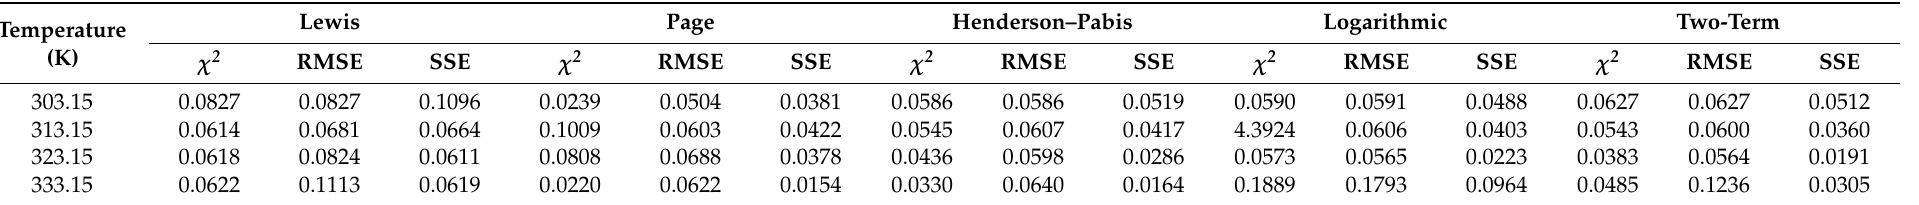
Table 3. Average values of goodness of fit criteria for drying models for Kyoho skin 1